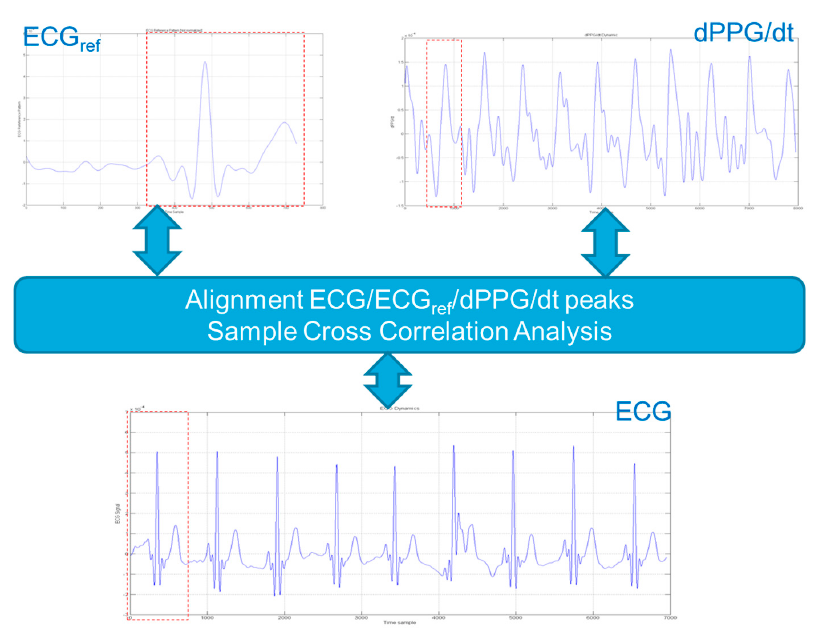
Figure 17. The system overview of the ECG pattern recognition pipeline based on sample cross-correlation of analyzed ECG waveform and ECG ref and dPPG/dt pattern.